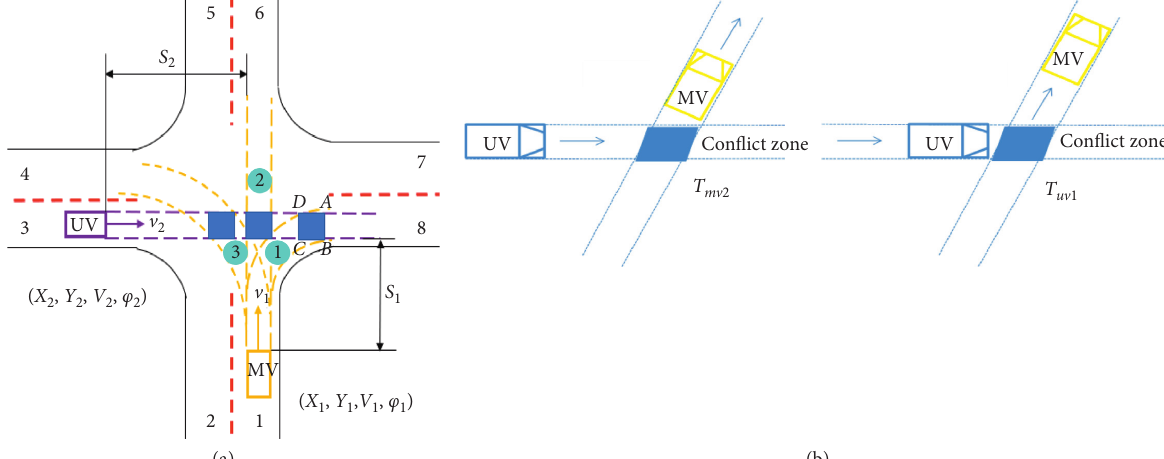
Figure 3: Scenes on crossing intersection with no